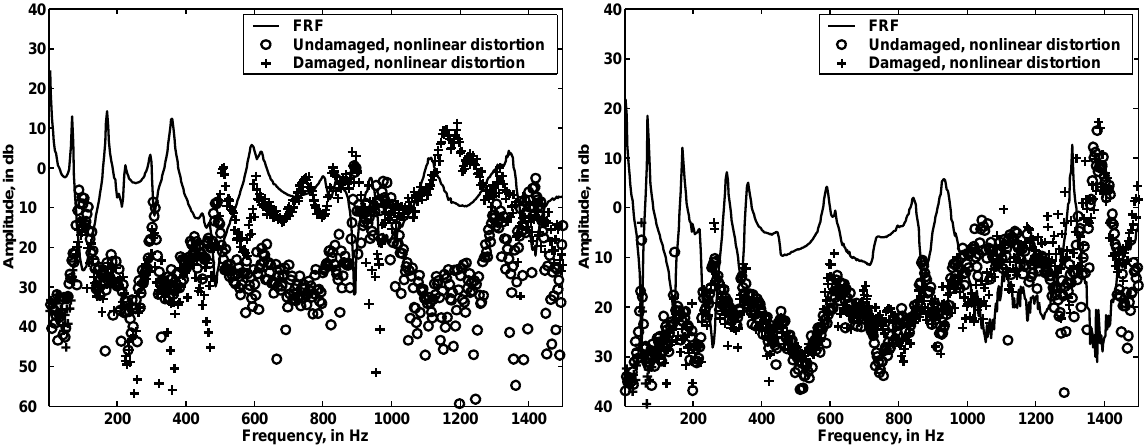
Fig. 11. Mean FRFs and nonlinear distortions extracted with the proposed spatial residual technique. Top: near the location of the delamination, bottom: opposite to the location of the delamination.